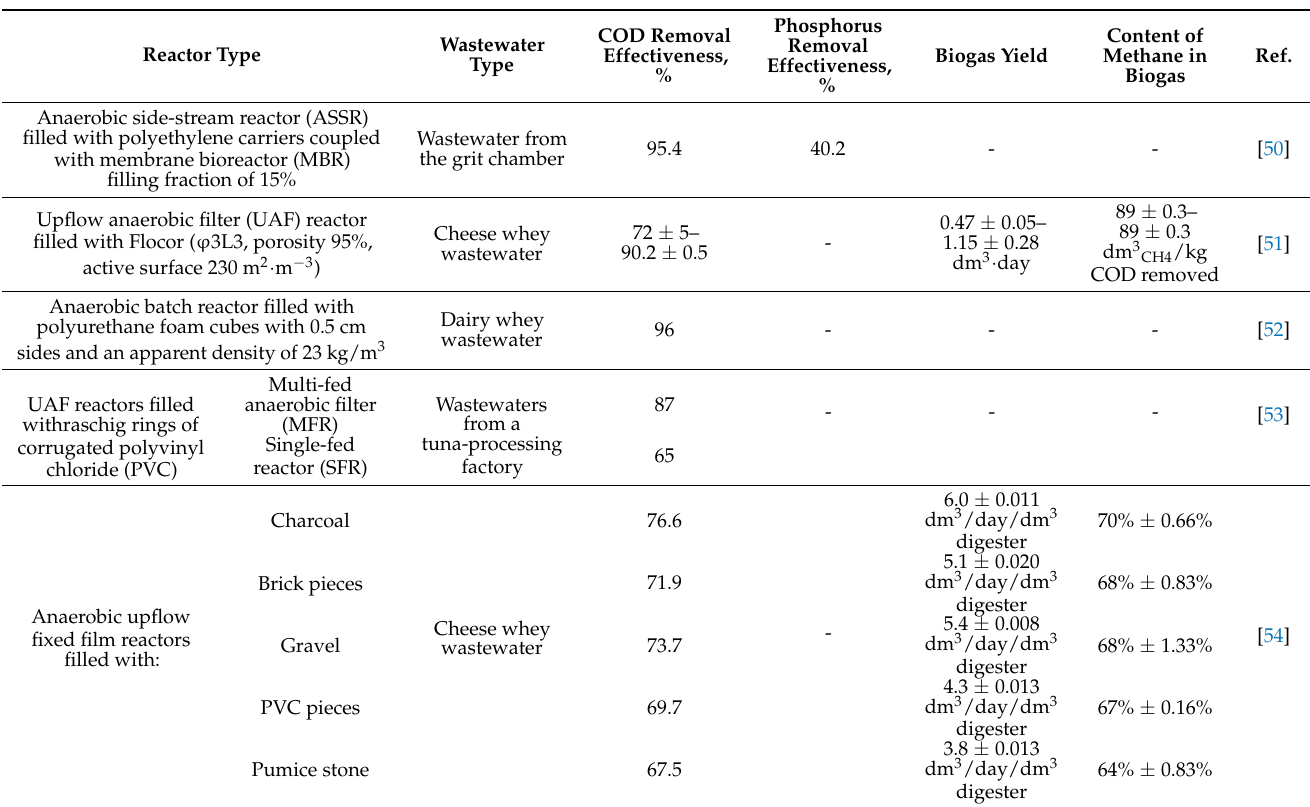
Table 4. Technological efficiency of other fillings used in the processes of anaerobic wastewater